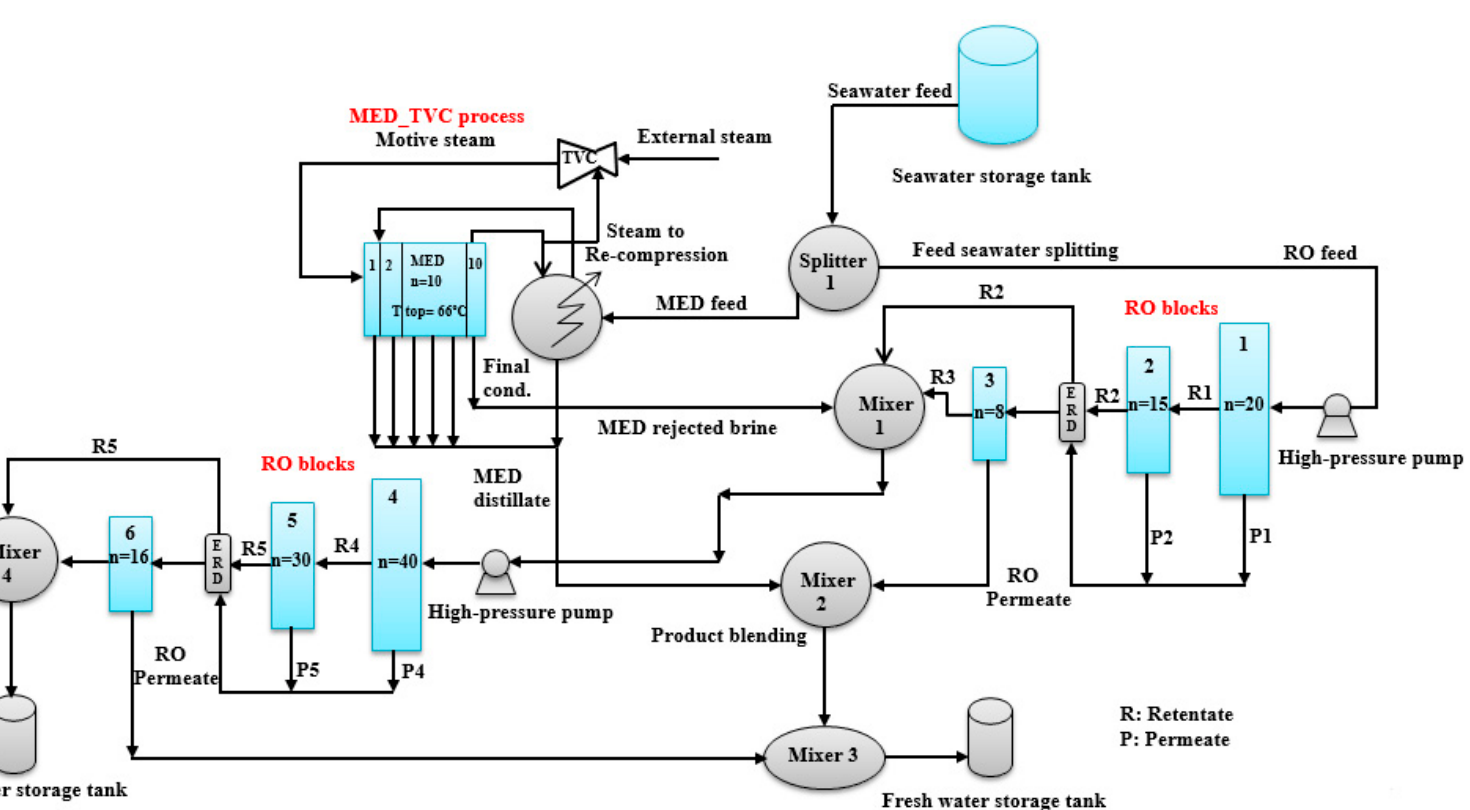
Figure 2. Schematic diagram of an integrated system of multi effect distillation and thermal vapour compression and double permeate reprocessing reverse osmosis processes.